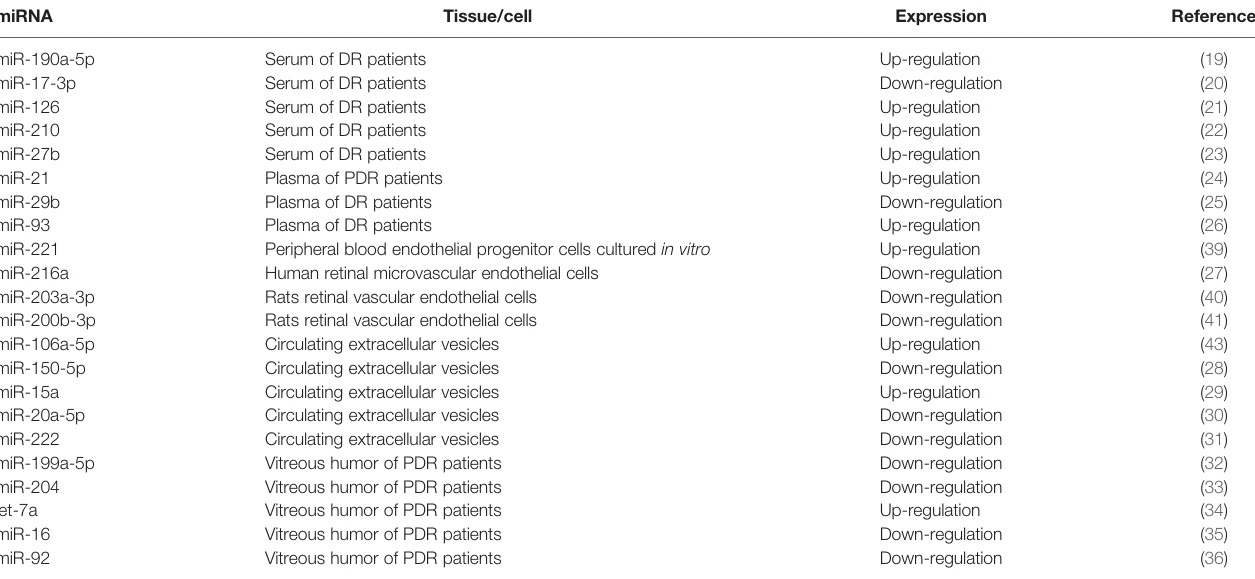
TABLE 1 | Circulating MiRNA Biomarkers of DR. miRNA